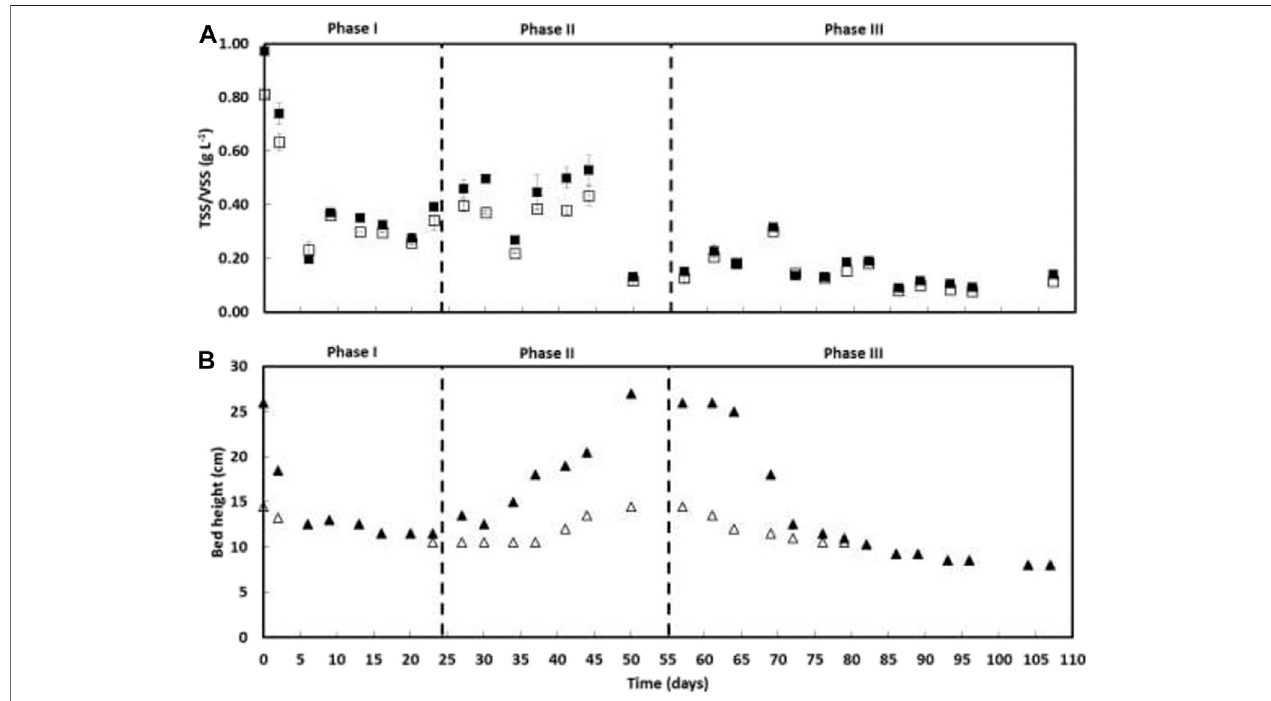
FIGURE 2 | TSS ( ■ ) and VSS ( □ ) concentrations in the outlet (A) and the biomass bed height (cm) (B) along AGS-SBR operation; The granular biomass ( Δ ) and granular plus suspended biomass bed height ( ▲ ) are shown.